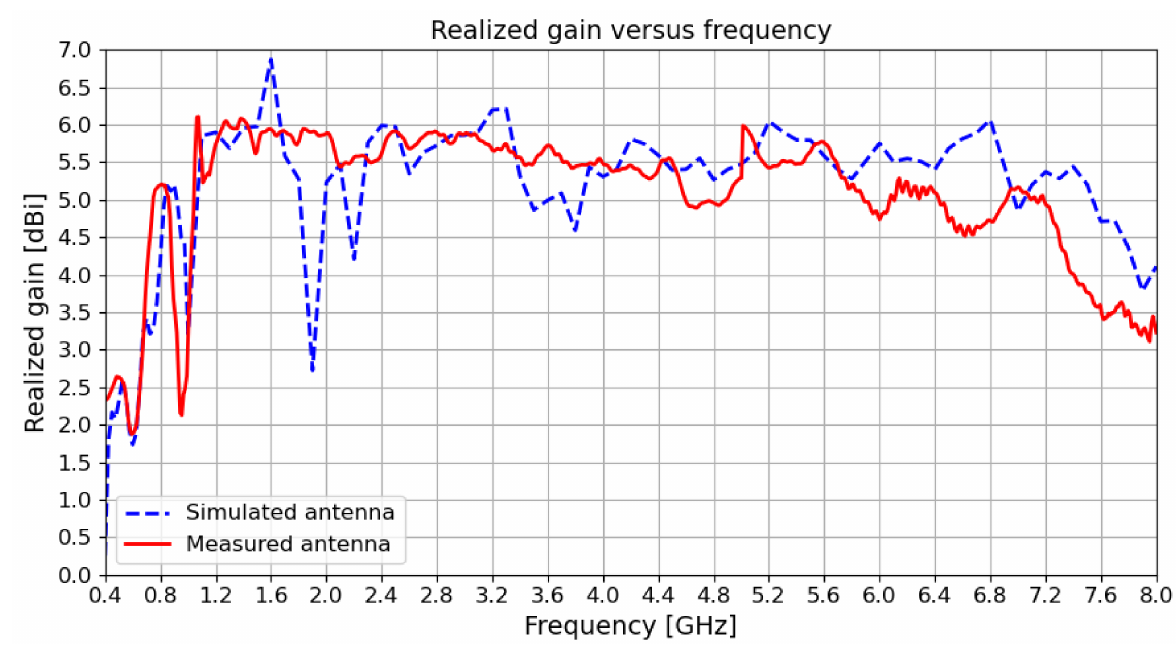
Figure 16. Realized gain of the improved PLPDA design.